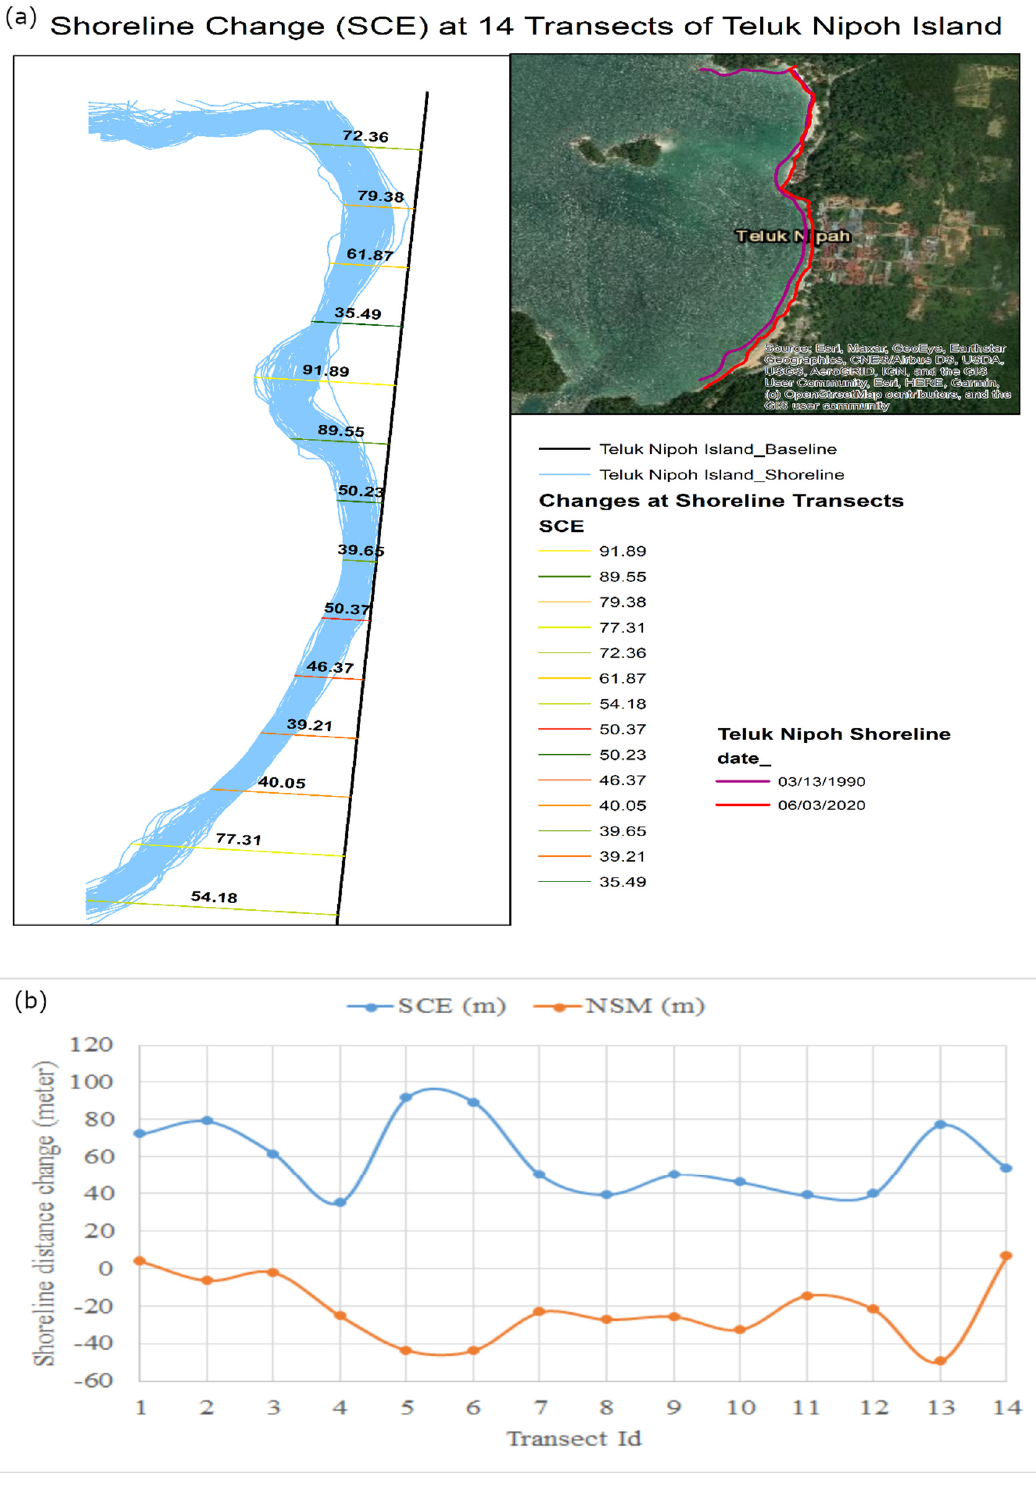
Figure 7. ( a ) Map of shoreline change (SCE). ( b ) Plot of shoreline distance change for SCE and NSM.